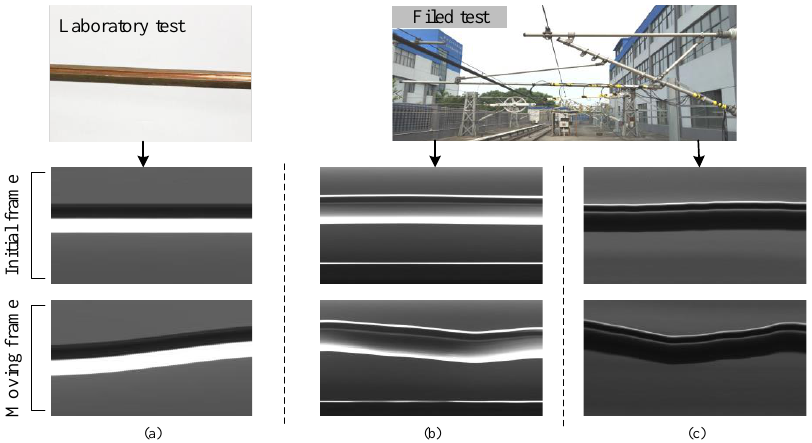
Figure 3. Structural schematic of the non-contact measurement devices employed for catenary vibration.